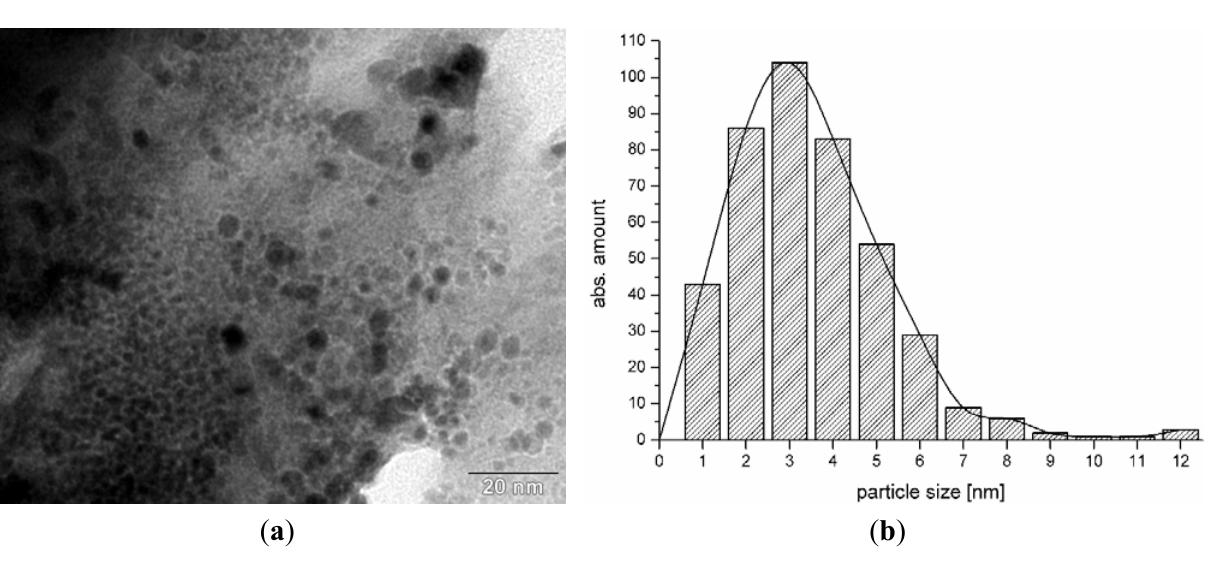
Figure 11. TEM measurement of 2Ru/La 2 O 3 –ZnO with an average particle size of 3.5 nm. TEM image of 2Ru/La 2 O 3 -ZnO ( a ) and the average particle size distribution ( b